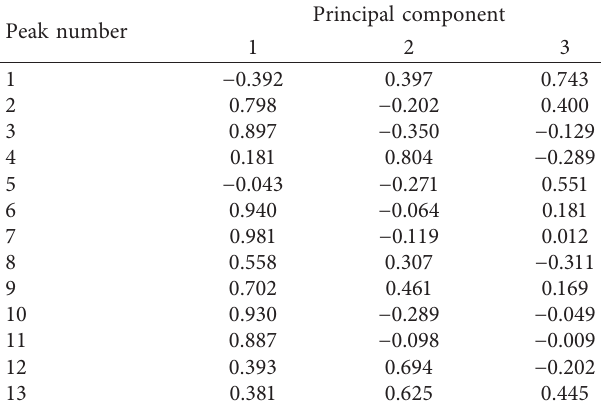
Table 4: Component matrixes.